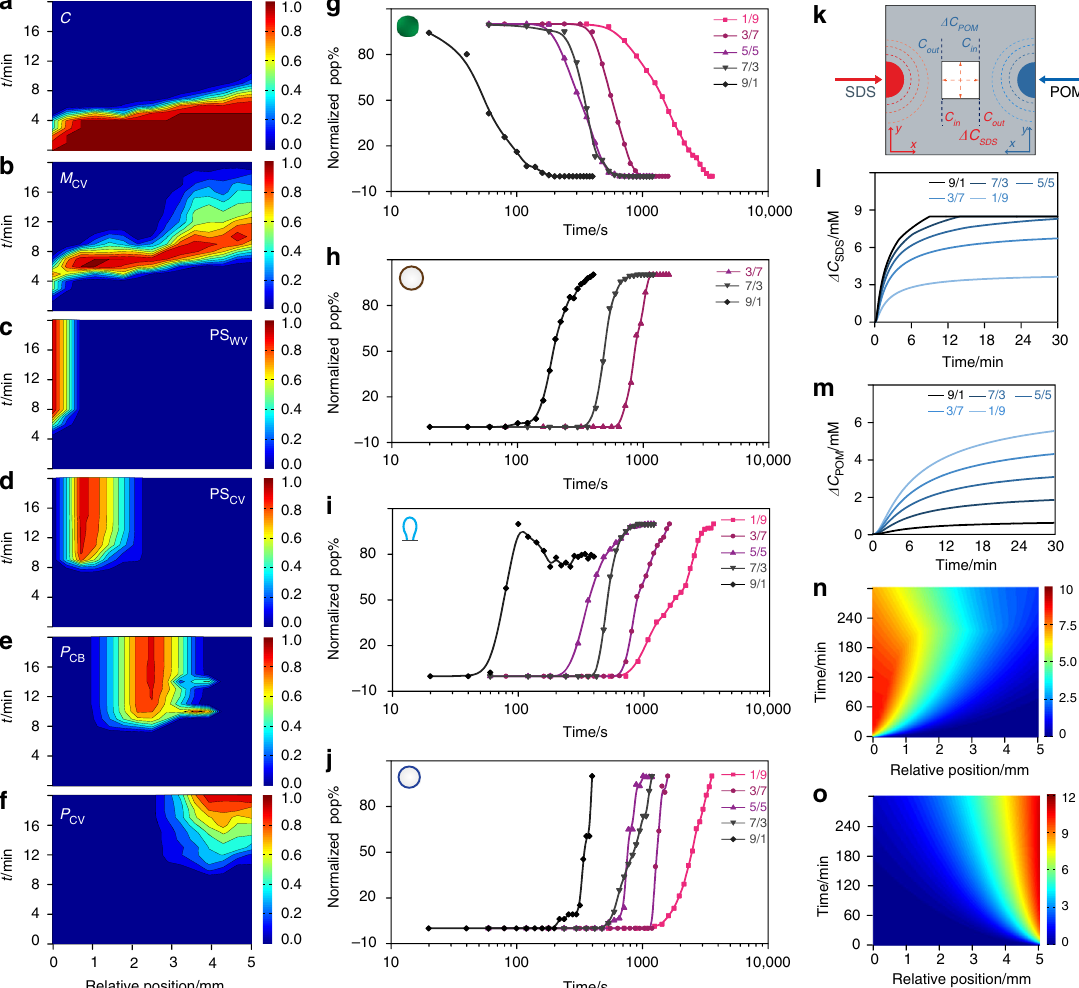
Fig. 4 Population dynamics under opposing gradients. a – f 2D colour plots of the spatial and temporal population distributions of differentiated protocell types produced in an opposing morphogen gradient (initial SDS : POM molar ratio = 2.3 (70/30mM)); a coacervate droplets ( C ); b multi- compartmentalized coacervate vesicles ( M CV ); c POM/SDS wrinkled vesicles ( PS WV ); d POM/SDS coacervate vesicles ( PS CV ); e balloon-shaped POM/ coacervate vesicles ( P CB ) and f spherical coacervate vesicles ( P CV ). Colour scale represents number fraction of a given population; n = 1500. g – j Plots showing time-dependent changes in normalized populations of native coacervate droplets C ( g ), and differentiated protocells PS CV ( h ), P CB ( i ) and P CV ( j ) in opposing morphogen gradients prepared under a range of initial SDS : POM molar ratios (9/1, 7/3, 5/5, 3/7). Data obtained from plots shown in a , d , e , f , respectively. k Simulation of opposing morphogen gradients in the central observation window (white square; 5 × 5 mm) of the acoustic trapping device. Changes in the SDS and POM concentrations perpendicular ( y -axis) or parallel ( x -axis) to the direction of diffusion are indicated (dashed red arrows in the centre square). The concentration gradients across the simulated area along the diffusion direction ( x -axis) are de fi ned as: Δ C = C in – C out . l , m Simulated time-dependent plots of the SDS concentration gradients ( Δ C SDS ) ( l ) and POM concentration gradients ( Δ C POM ) ( m ) established across the observation window and along the diffusion direction ( x -axis) for various opposing SDS/POM morphogen gradients (90/10, 70/30, 50/50, 30/70 and 10/90 µ L; 50 mM). The horizontal line shown in l represents the CMC of SDS. n , o Representative simulated 2D plots of the spatial and temporal distributions of SDS ( n ) and POM ( o ) concentrations for an opposing SDS/POM morphogen gradient of 2.3 (70/30 µ L; 50 mM) along the x -axis in the centre of the acoustic trapping device. Colour scale represents morphogen concentrations in mM. Source data are provided as a Source Data fi zones after ca . 8 min (Fig. 4c – e). In contrast, the M CV to P CV transformation within the POM-enriched intersection zone was kinetically delayed by approximately a further 2 min (Fig. 4f) prior to formation of a fourth segregated population. 2D spatiotemporal distribution plots for intersecting gradients produced at other SDS: POM ratios are shown in Supplementary Figs. 32-35. Plots of the time-dependent changes in the normalized populations for each morphological type under a range of opposing morphogen gradients indicated that in each case the decrease in number of native coacervate micro-droplets and